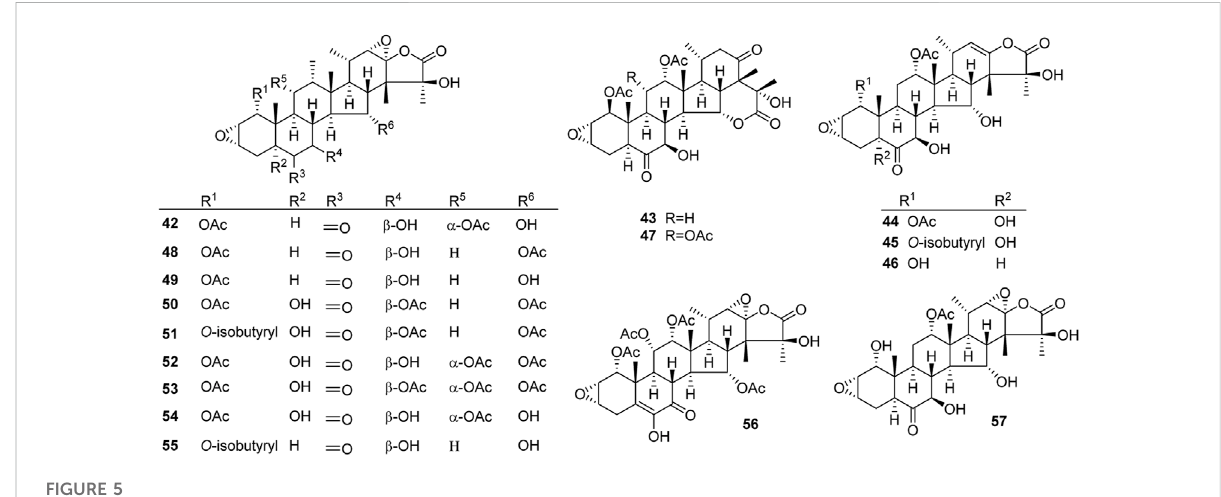
FIGURE 5 Structures of semi-synthetic